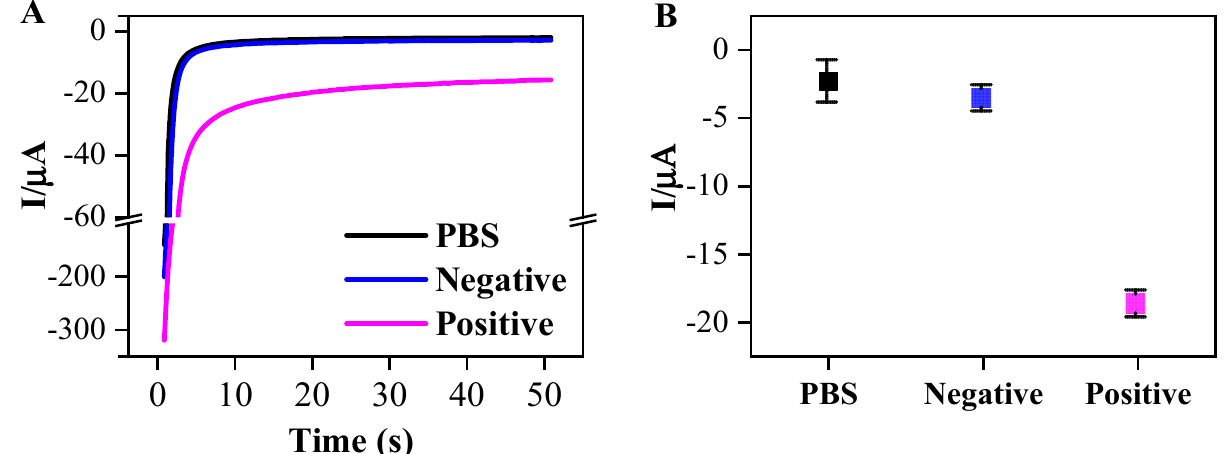
Figure 5 . ( A ) Chronoamperograms recorded with PBS, negative and positive controls. Applied potential of − 0.19 V vs. pseudo-Ag. ( B ) Current values on the steady-state, negative reference serum, and PBS.